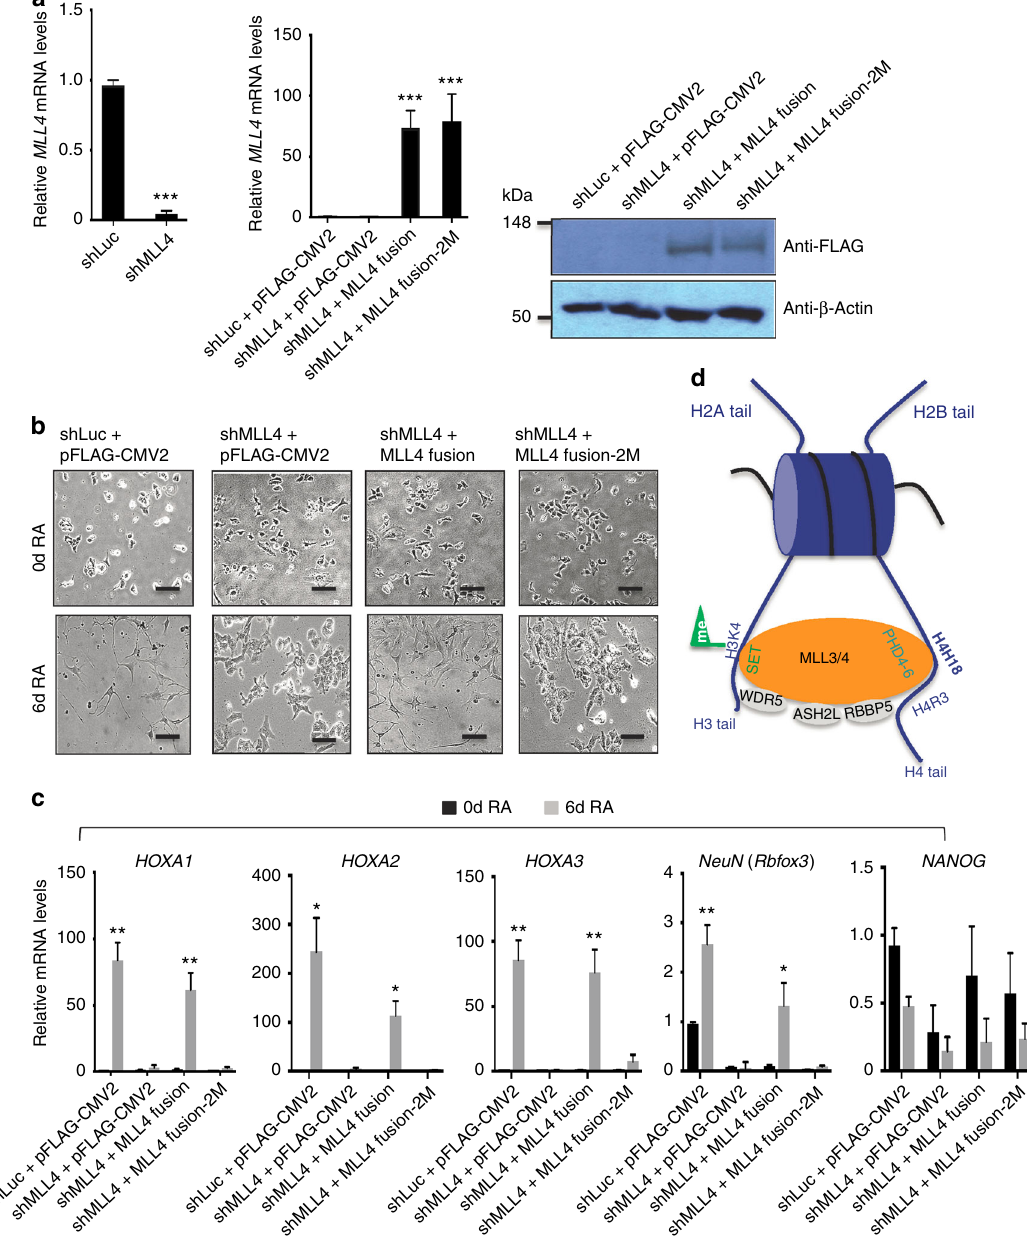
Fig. 4 The binding activity of ePHD 6 is essential for MLL4-mediated gene activation and cell-morphological changes during RA-induced NT2/D1 cell differentiation. a The ef fi ciency of knockdown of MLL4 by shMLL4 (left) and rescue by ectopic expression of MLL4 fusion or MLL4 fusion-2M (W1529A/ E1540A) (right) were examined by quantitative RT-PCR or western blot analysis. Data are presented as the mean ± SEM (error bars) of three independent experiments. Where indicated, statistical P -values were determined using two-tailed Student ’ s t -test. *** p < 0.001 indicate statistically signi fi cant differences. b The effect of ectopic expression of MLL4 fusion or MLL4 fusion-2M (W1529A/E1540A) on differentiation morphologies during RA-induced neuronal differentiation of shMLL4-treated NT2/D1 cells. Morphological changes during cellular differentiation were monitored using a microscope (10×). Shown are representative images of three independent experiments. Black scale bars, 50 µ m. c The effect of MLL4 fusion or MLL4 fusion-2M on expression of the HOXA1 ‒ 3, NeuN , and NANOG genes during RA-induced neuronal differentiation of shMLL4-treated NT2/D1 cells. Expression levels were measured by quantitative RT-PCR. Data are presented as the mean ± SEM (error bars) of three independent experiments. Where indicated, statistical P -values were determined using two-tailed Student ’ s t -test. * p < 0.05, ** p < 0.01, and *** p < 0.001 indicate statistically signi fi cant differences. d A possible model of the interaction between MLL3/4 and nucleosome. MLL3/4 are recruited to their targeted sites by the interaction between the PHD 4-6 (ePHD 6 ) domains and histone H4, and then the SET domains of MLL3/4 catalyze the methylation of histone H3K4 of the same or the nearby